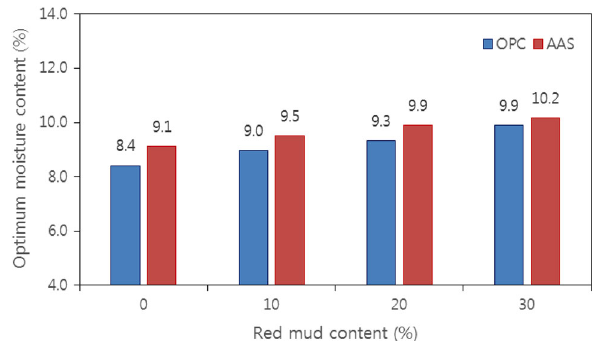
Fig. 6 Optimum moisture content with red mud replacement ratio.